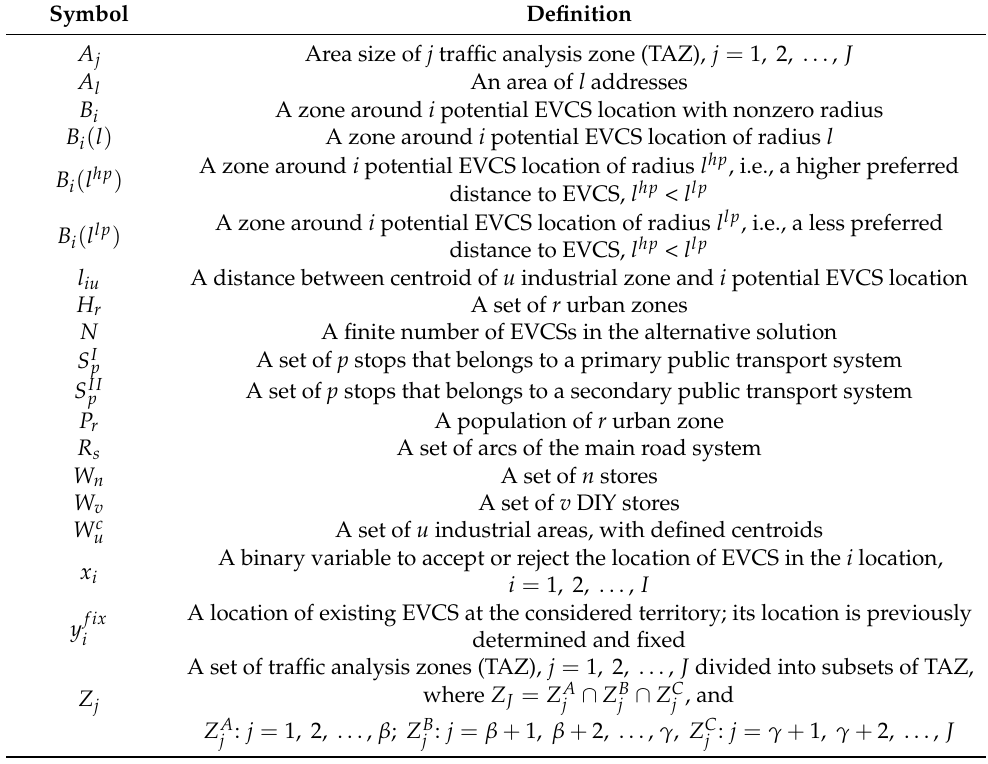
Table 2. This list of parameters and decision variables in alphabetical